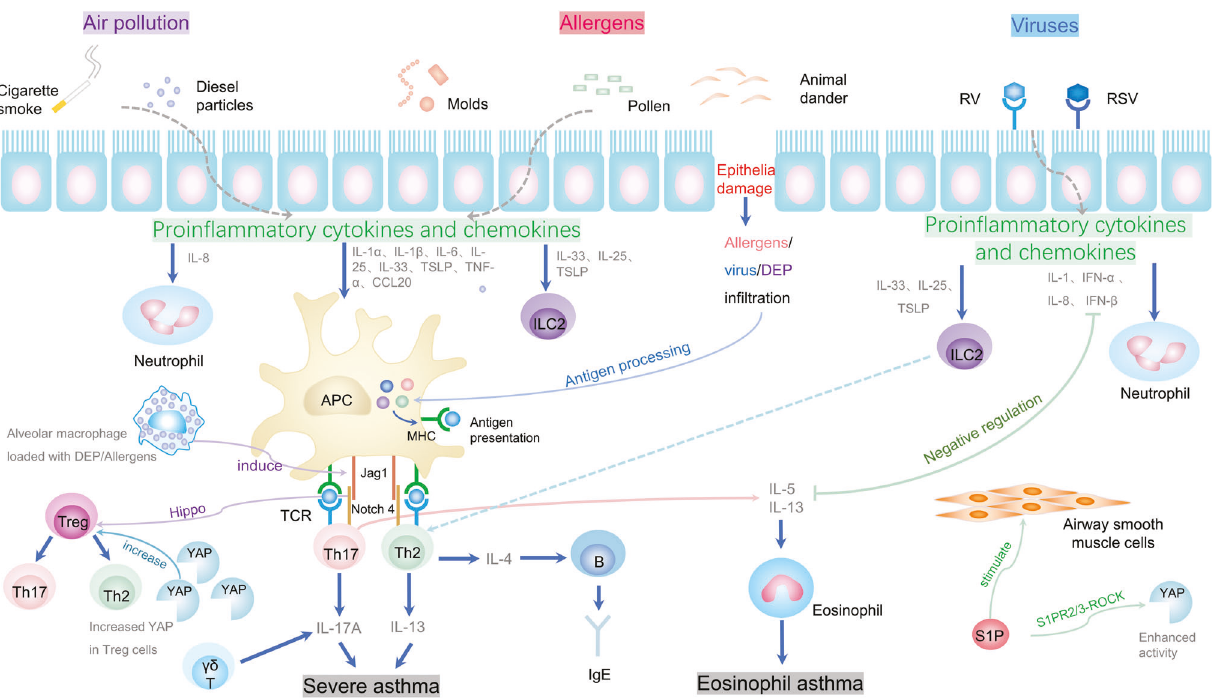
Fig. 6 The role of hippo signaling pathway in asthma. Exposure to air pollutants (cigarette smoke, diesel particles, etc.) and allergens (mold, pollen, animal dander, etc.) stimulates epithelial cells leading to the release of pro-in fl ammatory cytokines (IL-1, IL-6, TNF, etc.) and chemokines (IL-8, CCL20, etc.). Pro-in fl ammatory cytokines and chemokines act on congenital lymphocytes (ILC2s), neutrophils, and APC. Jag1 on APC binds to Notch receptors on T cells to activate Notch. Notch converts Treg cells into Th2 cells and Th17 cells through hippo pathway- dependent mechanisms, thus damaging the stability and function of Treg cells. Th17 cells and Th2 cells release active mediators, leading to airway smooth muscle contraction, increased viscosity secretion, and in fl ammatory cell in fi ltration, which trigger severe asthma. Meanwhile, Th2 cells produce interleukin (IL-4, etc.) to activate B cells to synthesize speci fi c IgE, which binds to IgE receptors on mast cells and eosinophils. If the allergen re-enters the body, it can cross-link with IgE binding to the cell surface, causing the cell to synthesize and release multiple active mediators, producing clinical symptoms of asthma. Interactions of respiratory viruses (RV and RSV) with speci fi c receptors in epithelial cells lead to the release of pro-in fl ammatory cytokines and chemokines and act on ILC2s and neutrophils, which promote differentiation of Treg cells into IL-13-producing Th2 cells in the absence of allergens. Notch and its downstream effector YAP were signi fi cantly increased in Treg cells of patients with severe asthma. Note: RV rotavirus, RSV respiratory syncytial virus, DEP diesel particles, CCL20 CC chemokine ligand 20, TNF tumor necrosis factor, IL interleukin, TSLP thymic stromal lymphopoietin, ILC2s group 2 innate lymphoid cells, APC antigen-presenting cell, Jag1 jagged1, S1P